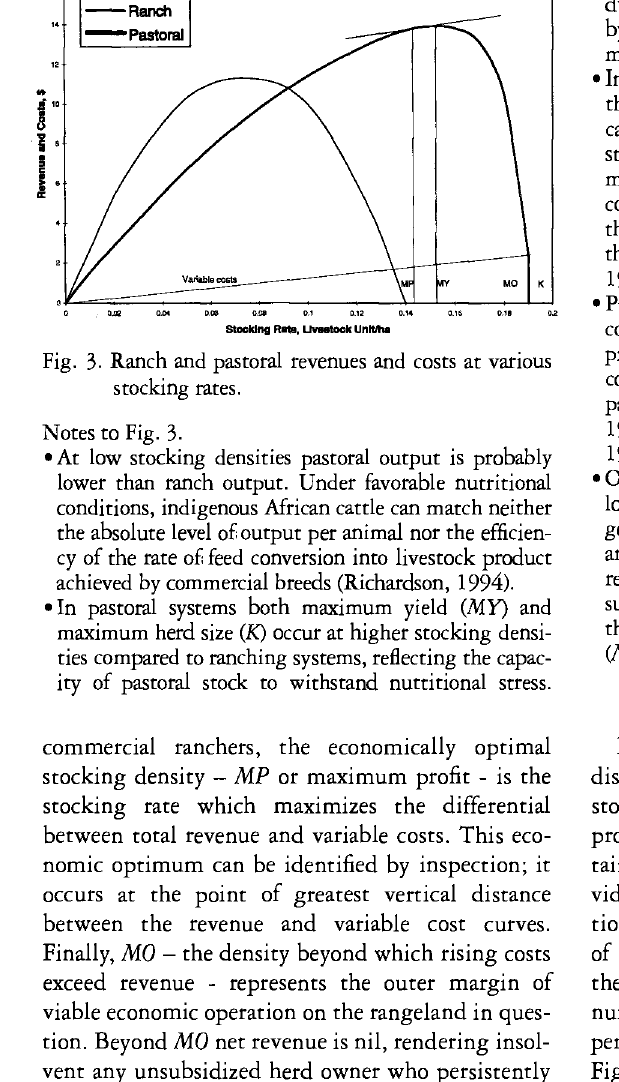
Fig. 3. Ranch and pastoral revenues and costs at various stocking